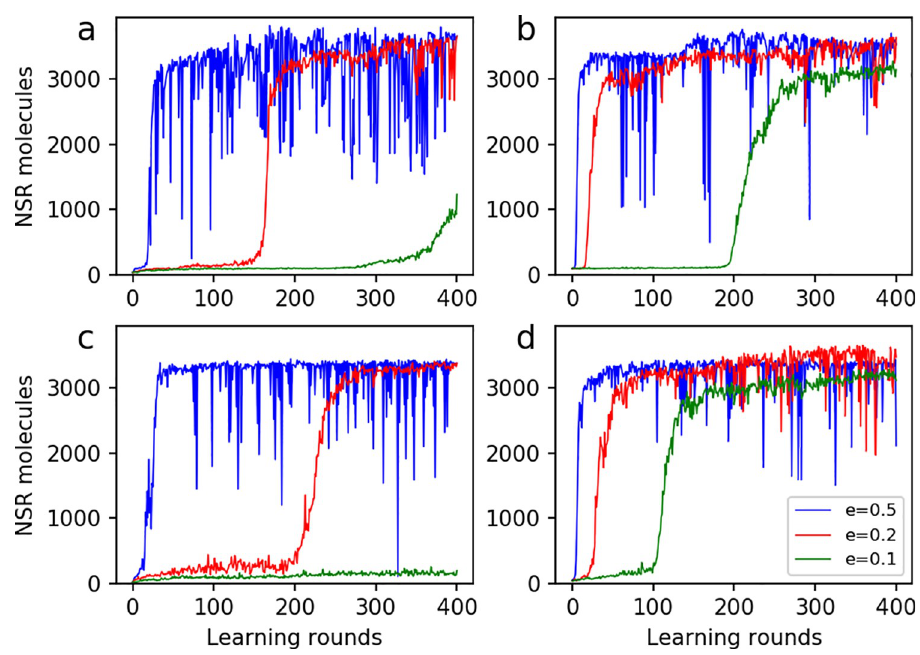
Fig 2. The improvement of the target NSR number by the automatic parameter-exploration in principle of machine-learning. The target NSR number refers to the number of NSR molecules at step 1.5 × 10 5 in the evolutionary dynamics (see Fig 1B; as the “objective function”). “e” denotes the learning rate (the color legend in the lower right subfigure applies to the whole figure). A round of learning means a round of parallel adjustment of all the eight parameters according to the greatest gradient (see Methods). The four subfigures show cases with different starting parameter values: ( a ) PNF = 4 × 10 − 3 , PNFR = 0.02, PND = 1 × 10 − 3 , PRL = 2 × 10 − 5 , PBB = 1 × 10 − 5 , PAT = 0.5, PFP = 0.1, and PMV = 1 × 10 − 3 (i.e., the same as those in Fig 1B); ( b ) PNF = 4 × 10 − 3 , PNFR = 0.2, PND = 0.01, PRL = 2 × 10 − 5